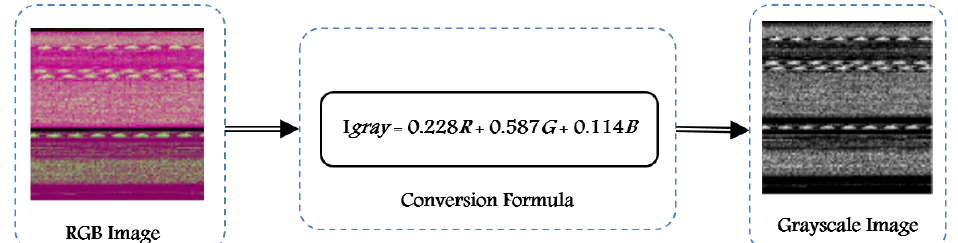
Figure 5. The Conversion Process Diagram.